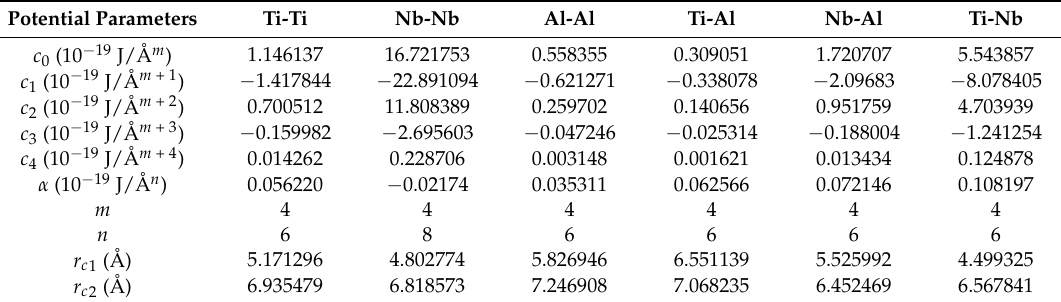
Table 2. The lattice constants ( a ), cohesive energies ( E c ), bulk modulus ( B 0 ), and elastic constants ( C ij ) of hcp-Ti, fcc-Ti and bcc-Ti fitted from potential and obtained by experiments [49] or ab initio. hcp-Ti fcc-Ti bcc-Ti Physical Properties Fitted